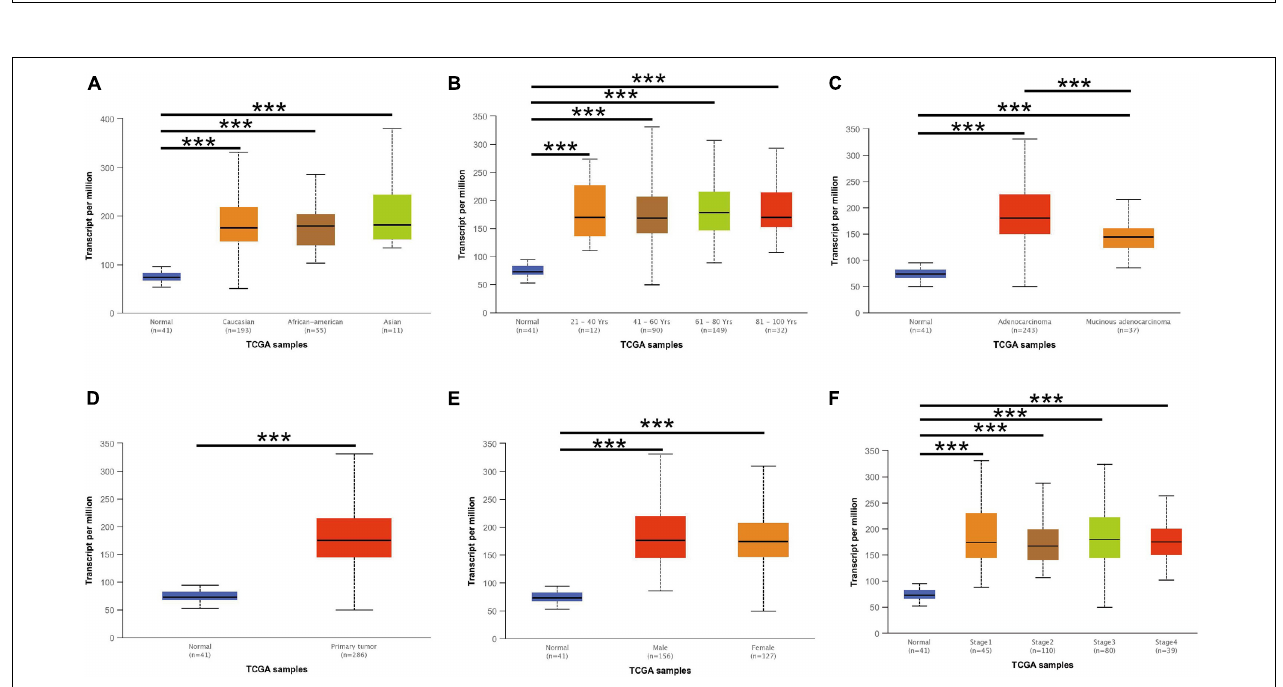
FIGURE 1 | CCT6A transcription in COAD (Oncomine). Levels of CCT6A mRNA was significantly higher in COAD than that in normal tissue. The fold change, associated p -values, and overexpression gene rank, are shown based on Oncomine 4.5 analysis. (A–F) The box plot shows CCT6A mRNA levels in the Notterman Colon, Kaiser Colon, Skrzypczak Colon Ki Colon, Hong Colorectal and Sabates-Beliver Colon datasets.